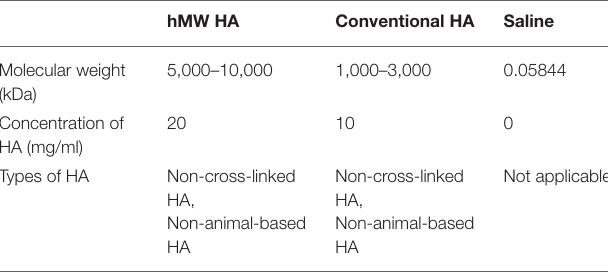
TABLE 2 | Properties of the three vehicles used in this